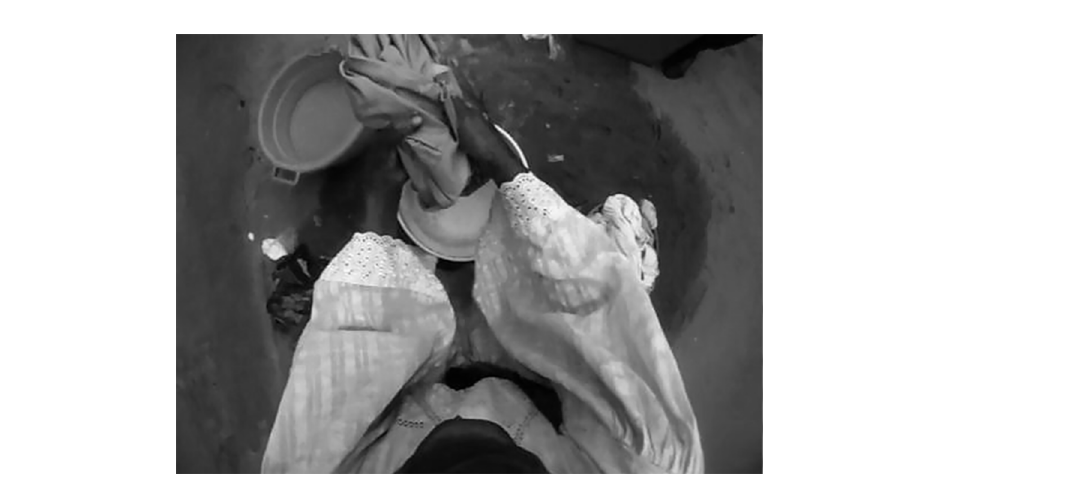
Fig 1. Field of view of video from Participant A, converted to